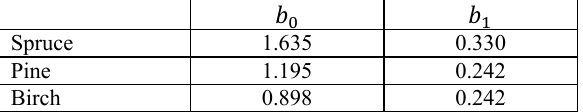
Table 1. The values of applied coefficients 𝑏 (cid:2868) and 𝑏 (cid:2869) ( Siipilehto and Kangas, 2015).